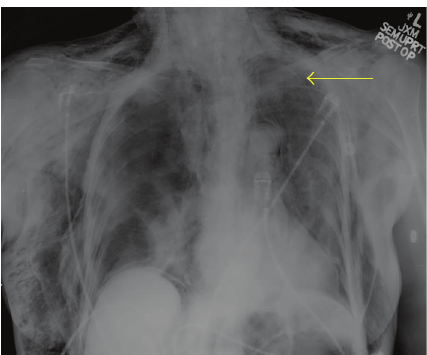
Figure 1: Portable chest X-ray showing subcutaneous emphysema, pneumomediastinum, and a left pneumothorax (arrow).